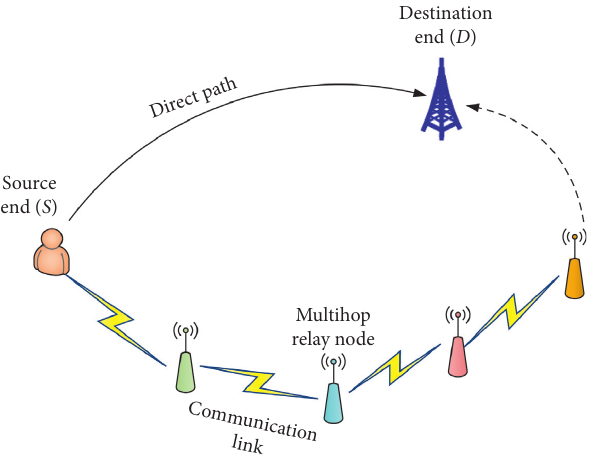
Figure 3: The relay cooperation network of an IoT